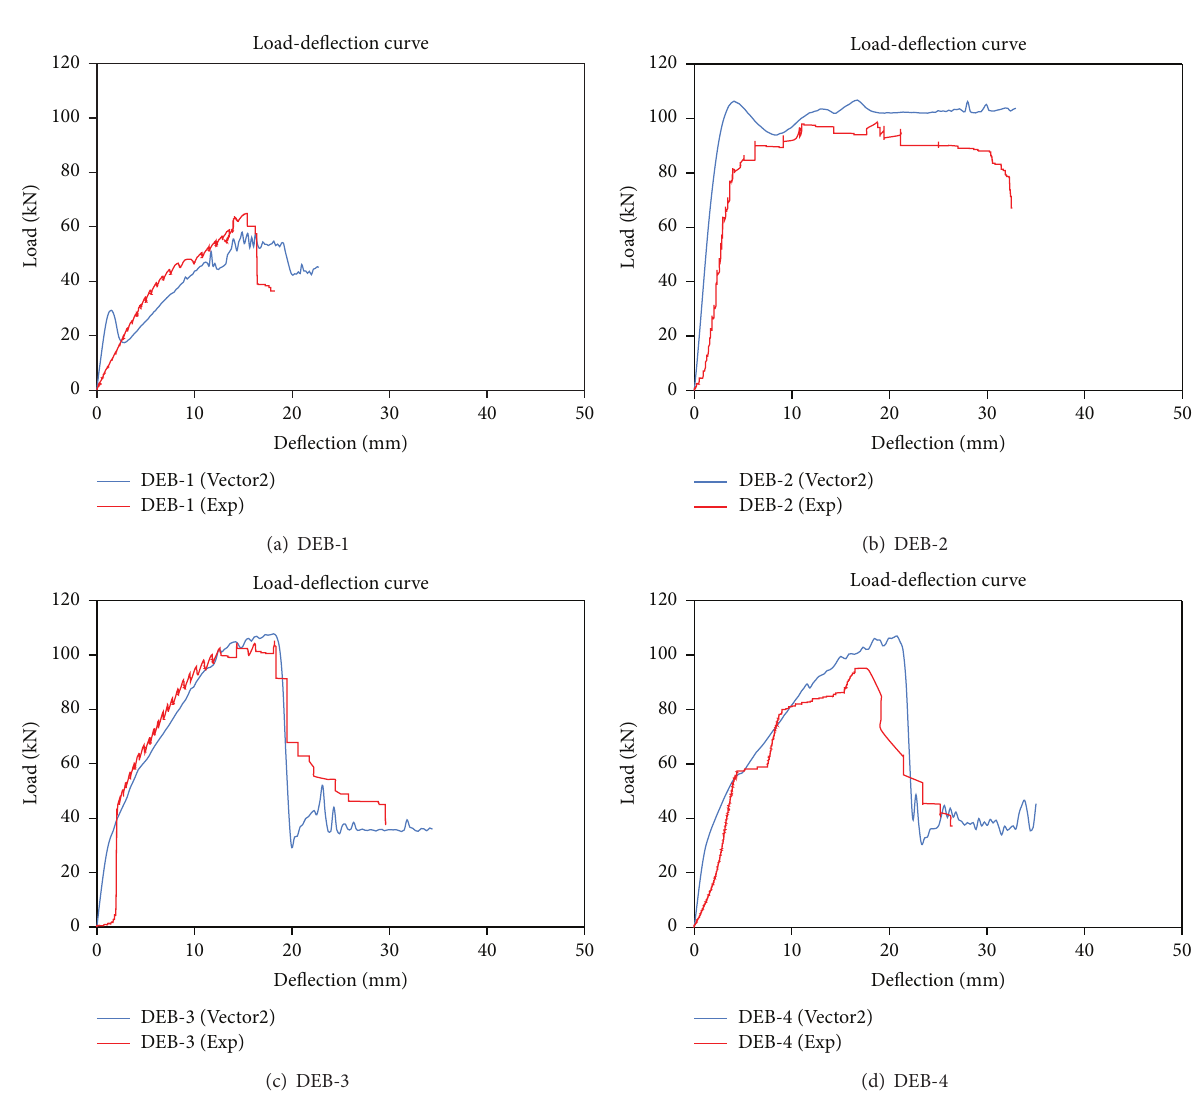
Figure 12: The load-deformation